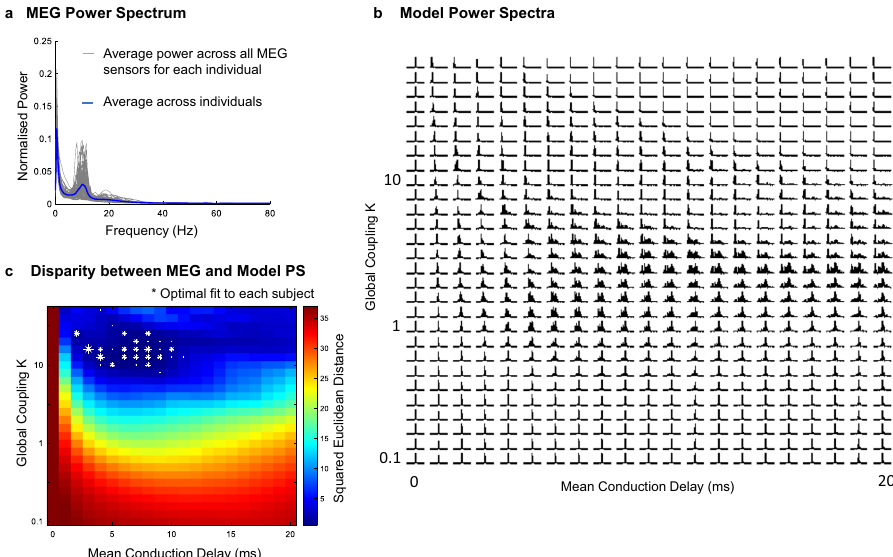
Fig. 3 Approximation of human magnetoencephalography (MEG) power spectra (PS) in a critical range of parameters. a MEG power spectra from 89 healthy young adults resting with eyes open from the open-source database of the Human connectome Project. The average power spectrum across individuals is reported in blue. b For each pair of parameters, the power spectra of the simulated signals (averaged across units and normalized between 0 and 80 Hz) is reported. c Squared Euclidean distance between the MEG power spectrum averaged across all sensors and subjects and the power spectrum of the simulated signals. Asterisks indicate the sets of parameters that optimally approximate the MEG power spectra of each of the 89 individuals (size scaled according to the number of subjects in each